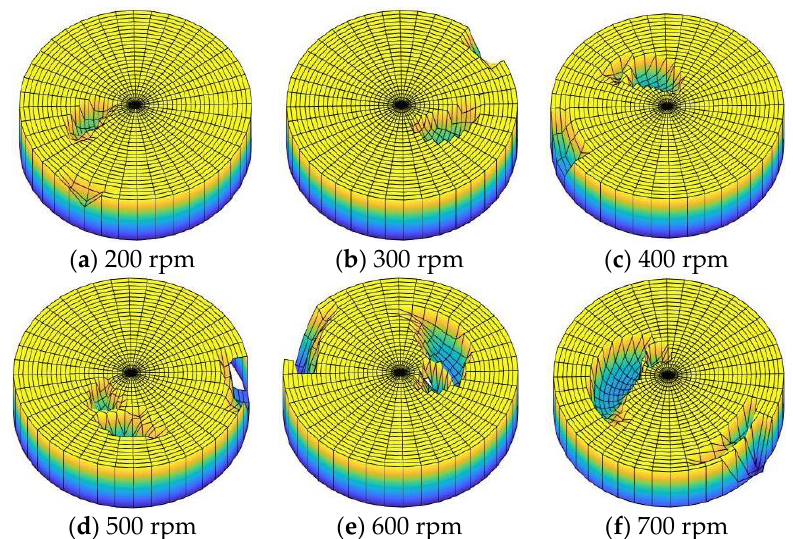
Figure 19. Scratch damage morphology on the workpiece surface with different workpiece speeds.